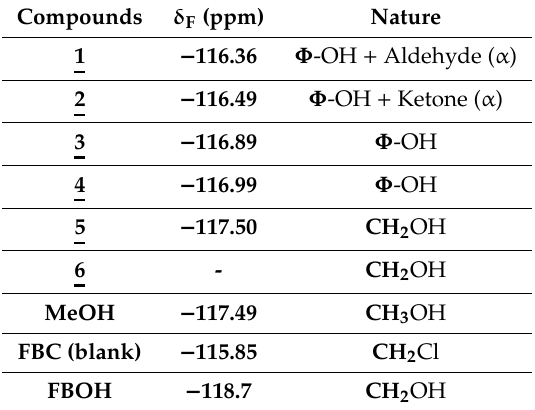
Table 5. 19 F-NMR chemical shifts (in ppm) of fluorobenzylated model